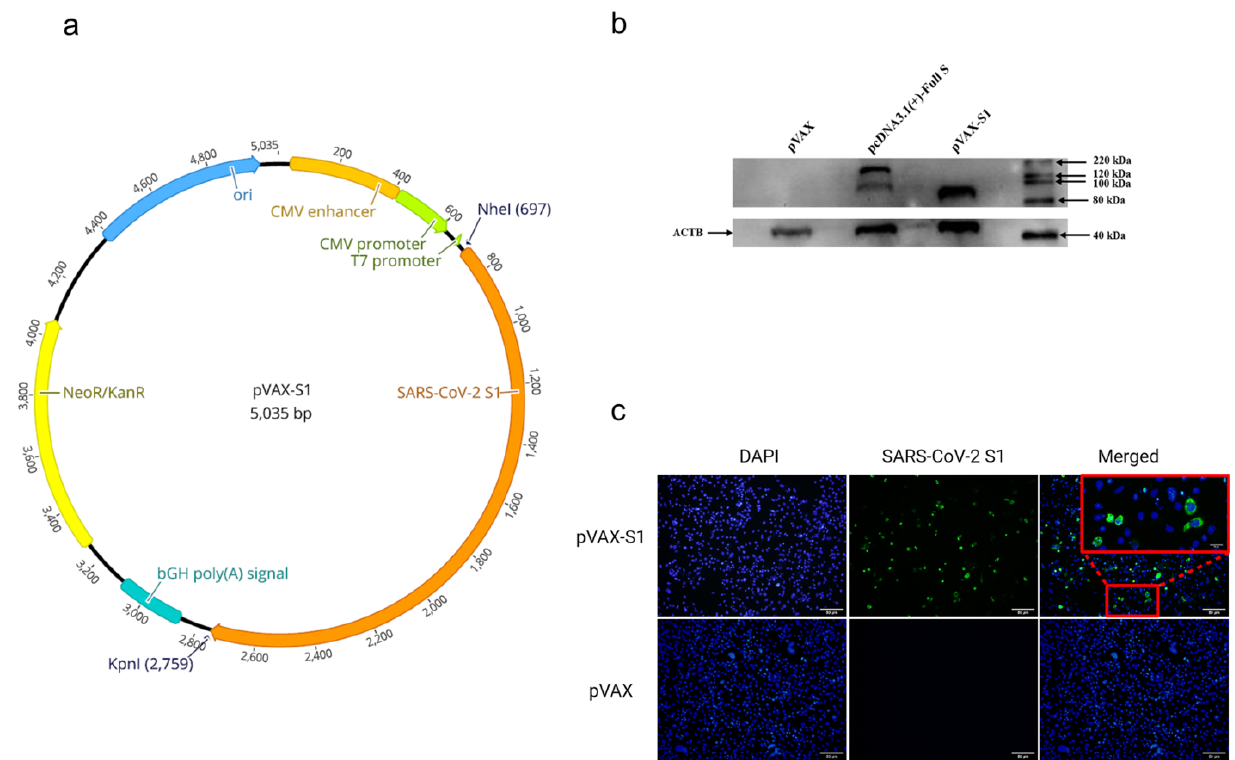
Figure 1. Vaccine design and characterization. ( a ) DNA vaccine (pVAX-S1) map. The inserted gene (SARS-CoV-2 S subunit 1) is indicated by orange color in the pVAX1 plasmid. ( b ) Western blot analysis. Figure shows bands of expressed full-length S from cells transfected with pcDNA3.1-Full S (positive control) and S1 subunit protein expressed from pVAX-S1. Empty pVAX was used as a negative control. ( c ) Immunofluorescence analysis. Cells transfected with pVAX-S1 or empty control pVAX were stained with anti-SARS-CoV-2 S rabbit polyclonal antibodies. Scale bars are 50 µm. Red square is magnified to scale bar of 10 µm. Merging and magnification were processed by ImageJ 1.53e.